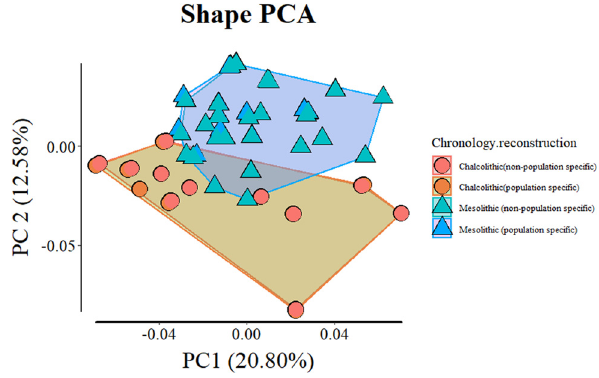
Figure A1: Shape PCA comparing population - speci fi c and non - population - speci fi c reconstruction of incomplete specimens. Note there is complete or almost complete overlap between specimens despite di ff erences in